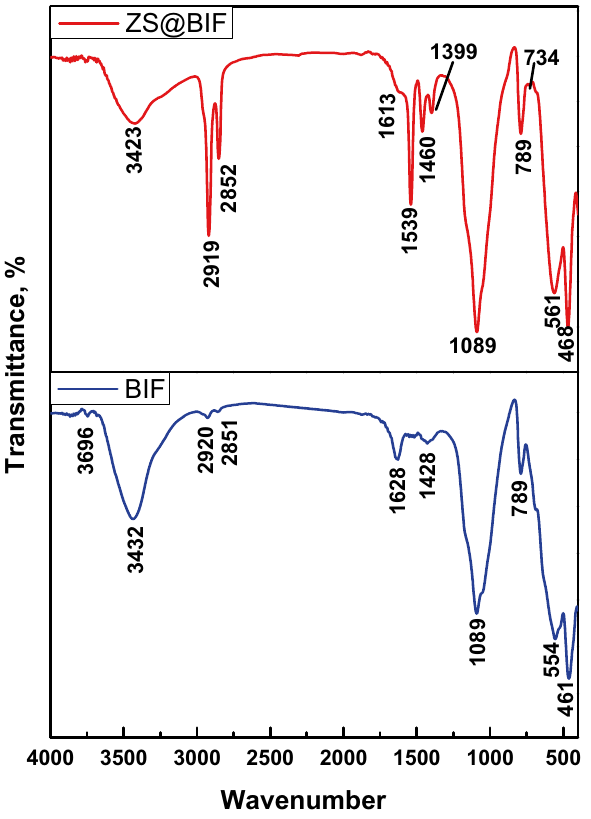
Figure 2. FTIR spectra of BIF and 20% ZS@BIF